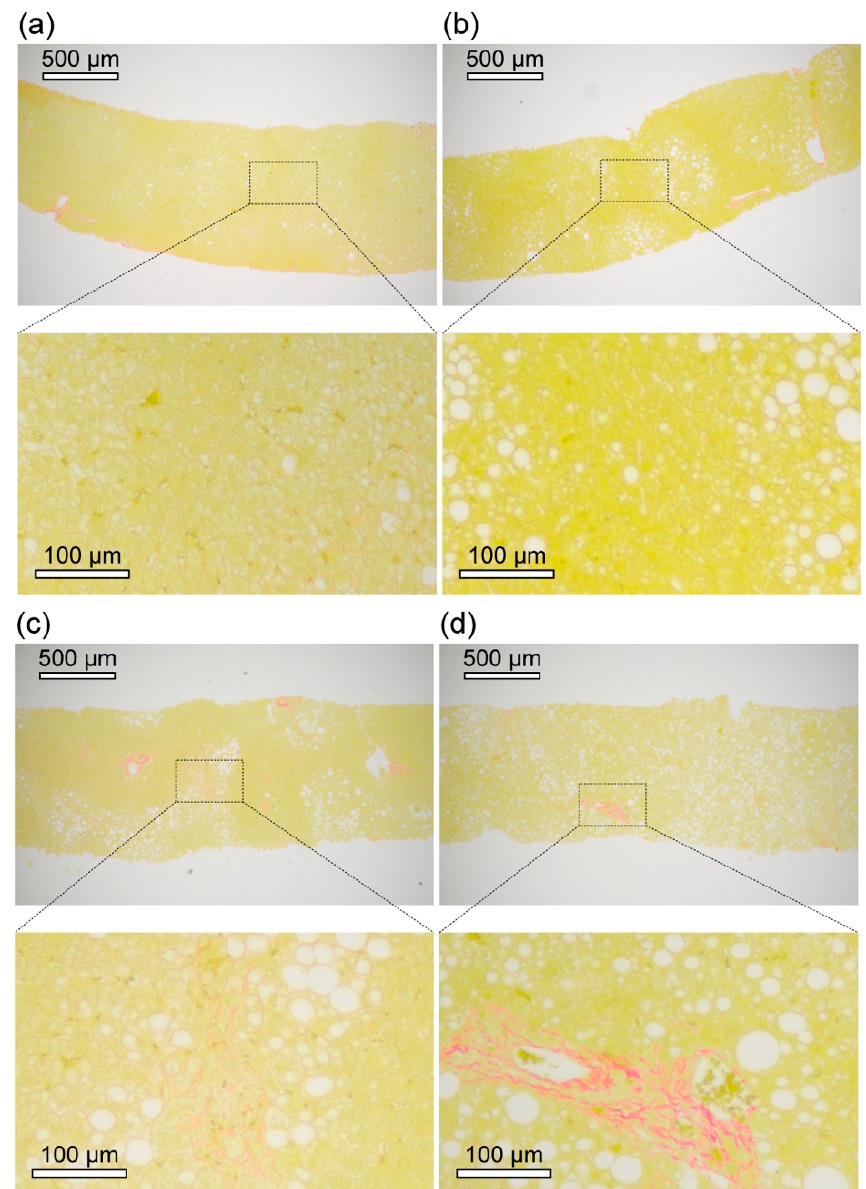
Figure 1. Sirius Red-stained images of the livers of representative NAFLD patients. Sirius Red- stained-images of livers of ( a ) ultra-early stage of NAFLD (Patient 1), ( b ) ultra-early stage of NAFLD (Patient 2), ( c ) early stage of NASH (Patient 3), and ( d ) advanced stage of NASH (Patient 4).